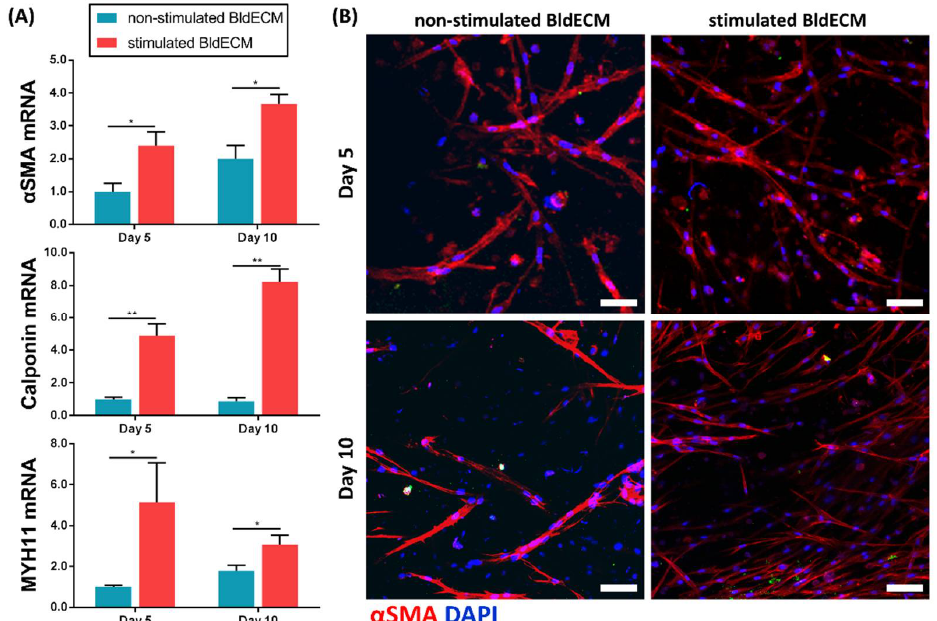
Figure 5. Effect of physiological stimuli on myogenesis in the engineered bladder model. ( A ) Changes in mRNA expression levels of myogenic markers ( α -SMA, calponin, and MYH11) in the non- stimulated and stimulated BldECM groups at days 5 and 10 (* p < 0.05 and ** p < 0.01), and ( B ) Immunofluorescence staining of alpha-smooth muscle actin ( α SMA) in the non-stimulated and stimulated BldECM groups on days 5 and 10 (scale bar = 100 µ m); α SMA (red), DAPI